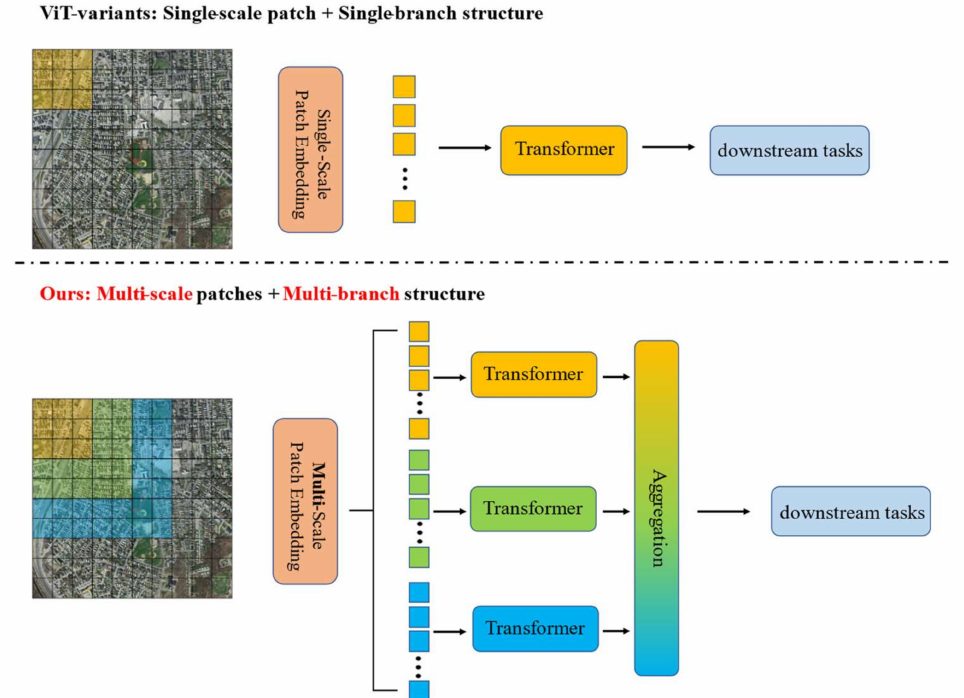
Figure 1. Top: single branch Transformer structure with single scale patch such as ViT-variants. Bottom: HA-RoadFormer, a multi-branch Transformer structure with multi-scale